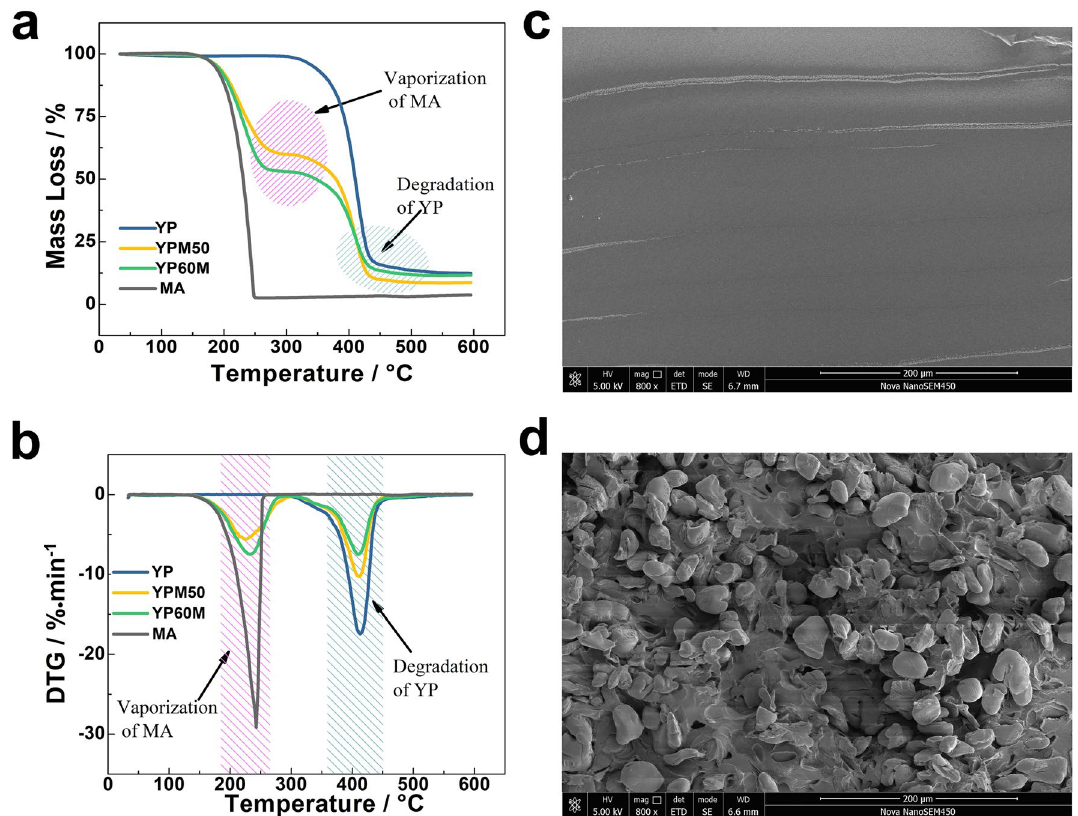
Figure 7. The ( a ) TGA curves of YP, YPM50, YPM60 and MA ( b ) DTG curves of YP, YPM50, YPM60 and MA ( c ) SEM images of YP ( d ) SEM images of YPM50.